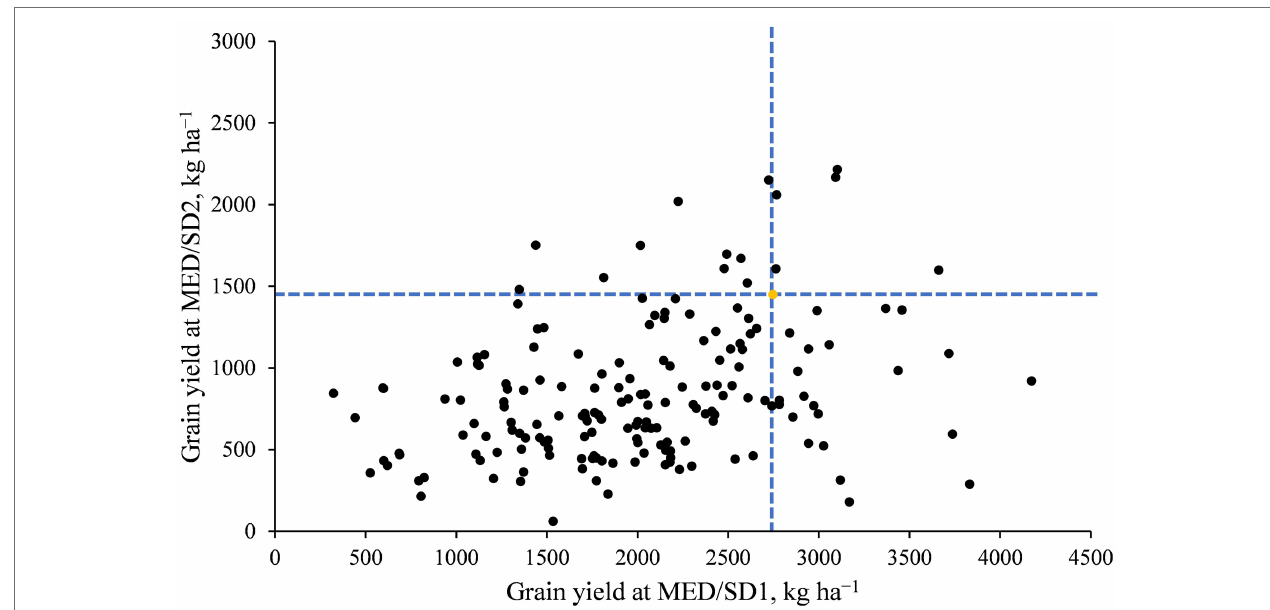
FIGURE 2 | Average grain yield of the MDLs in Wad Medani for the second sowing date (MED/SD2) versus that in Wad Medani for the first sowing date (MED/ SD1). The dashed blue lines intersect on the recurrent parent “Miki 3” (yellow circle). A few MDLs showed higher grain yield than their recurrent parent ‘Miki 3’ for both MED/SD1 and MED/SD2.